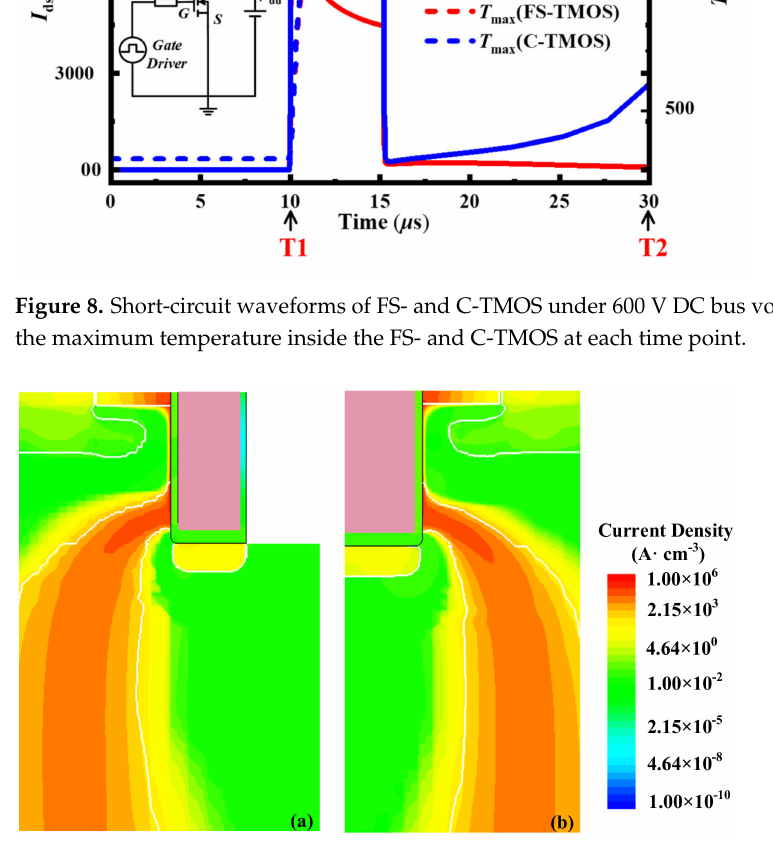
Figure 9. Current distribution inside ( a ) FS- and ( b ) C-TMOS at the time point T1. Although the gate channel is turned off after 15 µ s, the C-TMOS is out of control afterwards, while the FS-TMOS survives. During this process, the junction temperature is high enough to make minor carrier increase exponentially, which results in a current path between drain and source terminal. If the dissipated power exceeds the power moving away from device, the temperature continues to increase, leading to device failure. The electron and hole distribution and formed current of FS- and C-TMOS at the time point T2 are shown in Figure